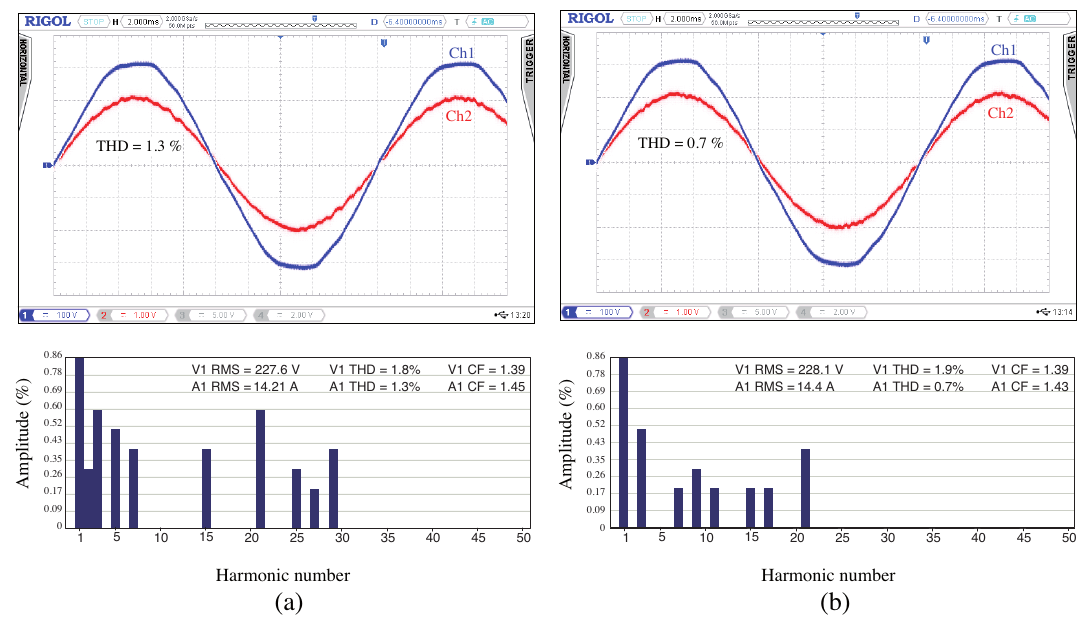
Figure 12. Grid current and harmonic content at nominal 10 kVA using the CE technique in a CCF with PI control and grid-voltage feedforward ( a ) and GCF with PR control ( b ). Ch1: grid voltage (100 V/div). Ch2: grid current (10 A/div).